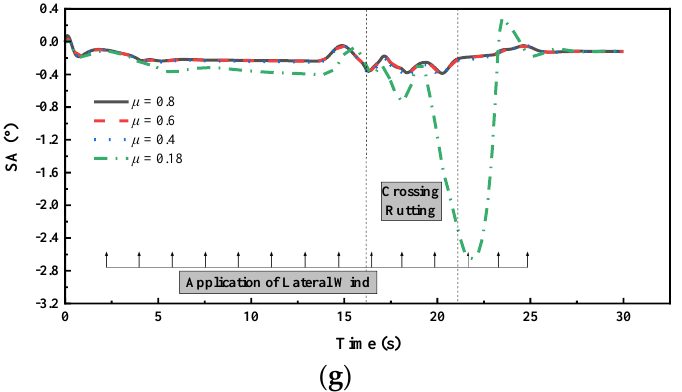
Figure 9. Change of SA over time under various driving conditions: ( a ) Vehicle speed; ( b ) WHR of the rutting; ( c ) Radius of circular curve; ( d ) Superelevation; ( e ) Crosswind angle; ( f ) Wind speed; ( g ) Friction coefficient between road & tire.